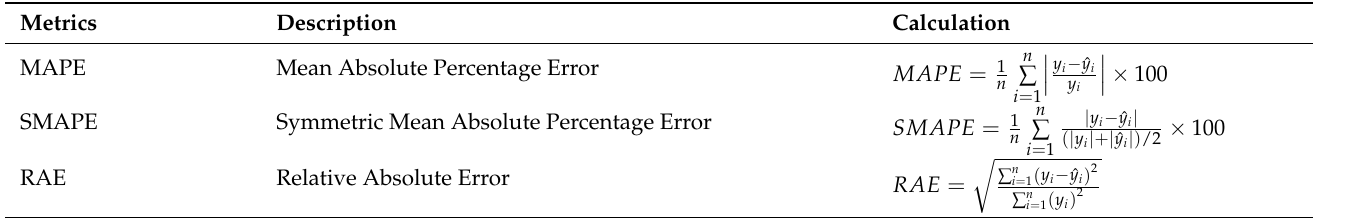
Table 2. Equation of Performance